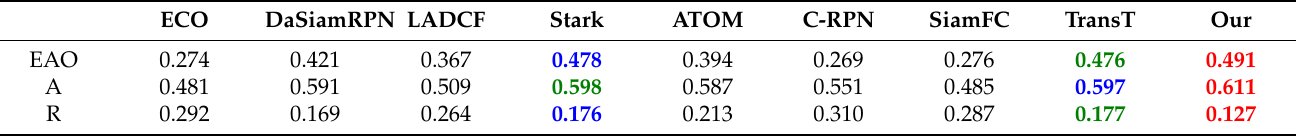
Table 2. Comparison with state-of-the-art trackers on VOT-2018 ( Red , Blue , and Green represent the top three tracking effects. The bigger the EAO and A, the better the reverse R).